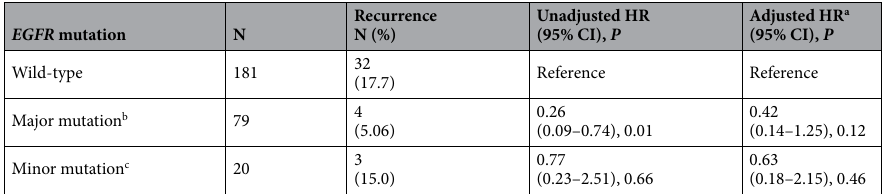
Table 4. The Cox proportional hazards analysis of RFS according to the EGFR mutation status. RFS recurrence-free survival, EGFR epidermal growth factor receptor gene, HR hazard ratio, CI confidence interval, by PD-L1 expression status, pathological stage, histological type and adjuvant chemotherapy. b Ex21 or Ex19. c Defined as all mutations except Ex21 and Ex19.